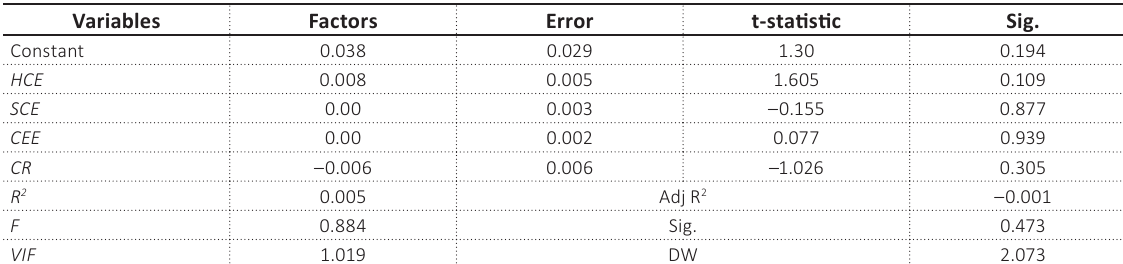
Table 5. The second model